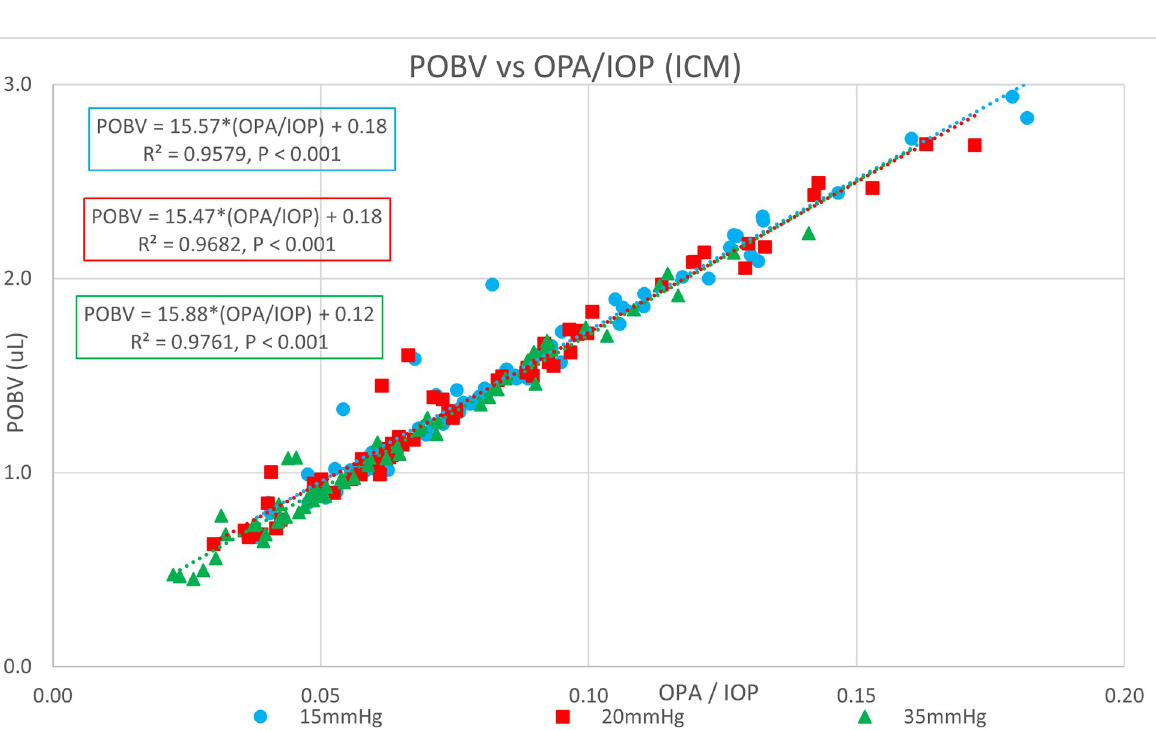
Fig 8. Strong correlation of the Calculated POBV to the Factor OPA/IOP for ICM Measurements.